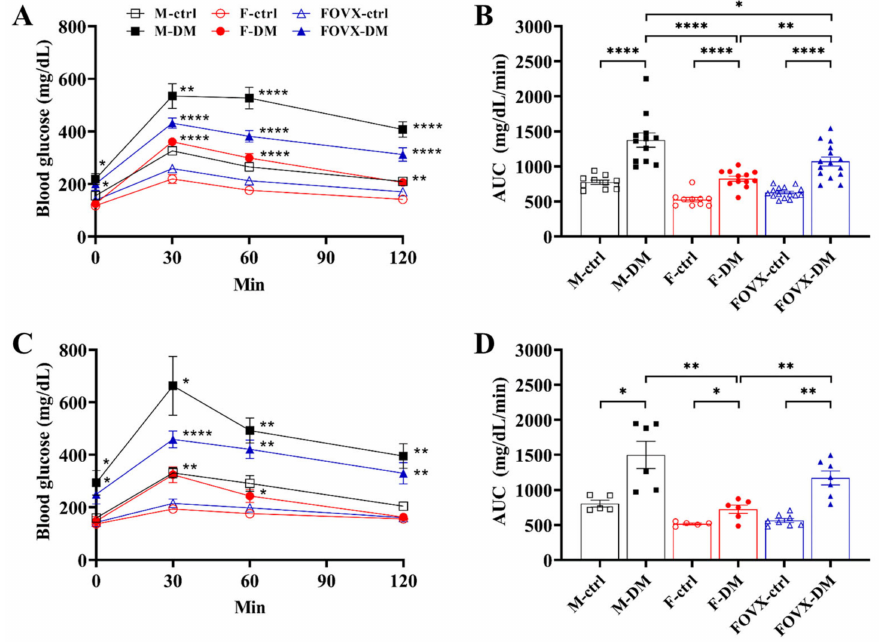
Figure 2. Results of oral glucose tolerance test (OGTT) in STZ-treated diabetic mice. OGTT results and area under the curve (AUC) at weeks 3 ( A , B ) and 6 ( C , D ) after STZ treatment. Glucose tolerance of the FOVX-DM group was worse at week 6 than at week 3, indicating that the ovaries play an important role in glucose metabolism. Data were analyzed using an independent two-sample t -test. * p < 0.05, ** p < 0.01, **** p < 0.0001 compared with the respective control